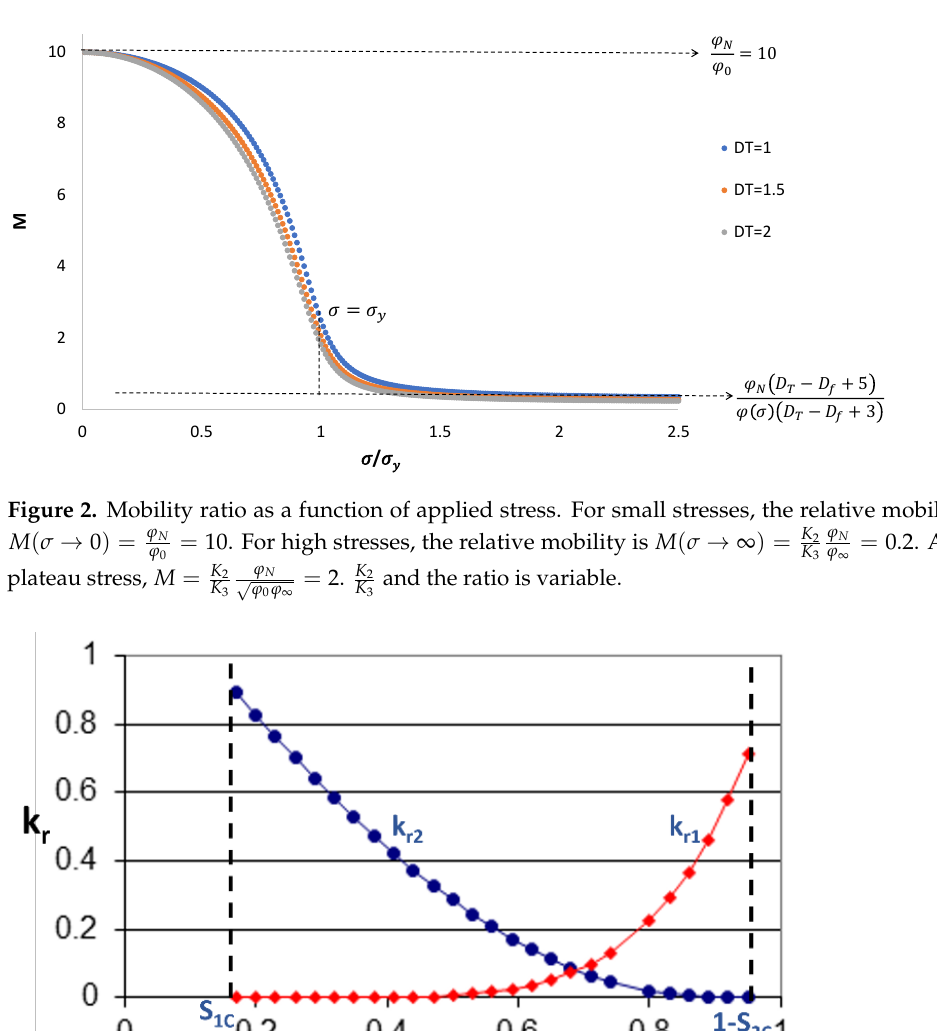
Figure 1. Normalized fluidity as a function of the stress normalized by the plateau stress. When the normalized stress is equal to one, the fluidity is ( ϕ ∞ / ϕ 0 ) 1/2 = 10, which coincides with ϕ N / ϕ 0 = 10.